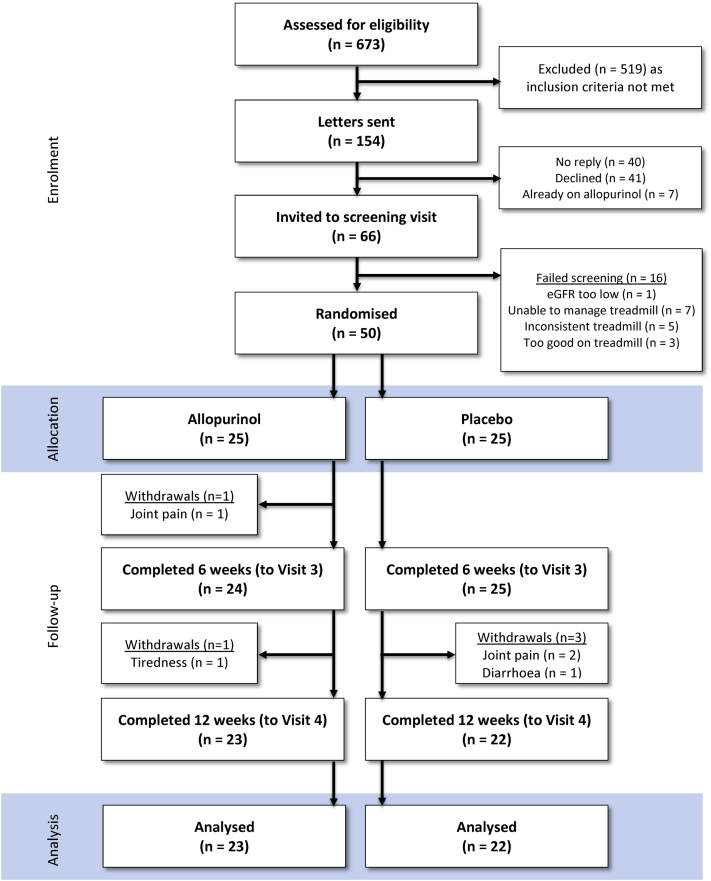
Consolidated Standards of Reporting Trials diagram.